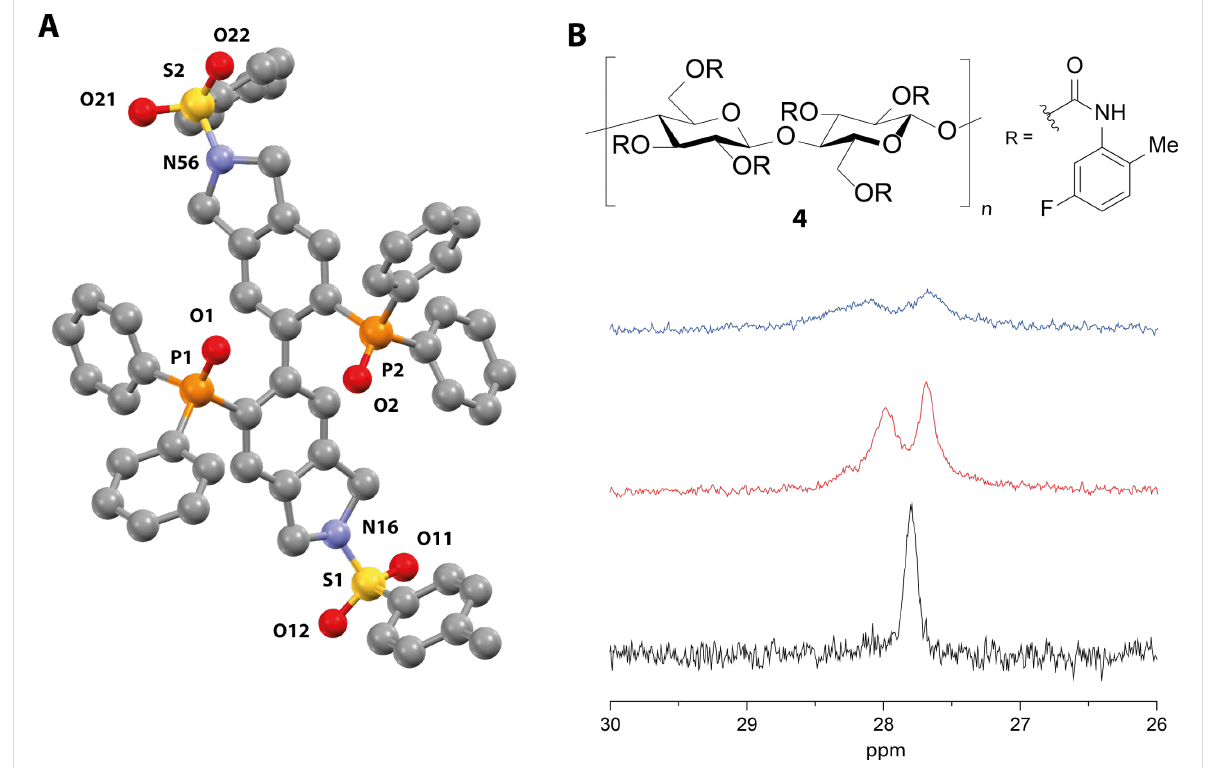
Figure 3: Investigation of “NU-BIPHEP(O)” 1b . A) Solid-state structure determined by X-ray crystallography. Hydrogen atoms and methanol solvent molecules are omitted for clarity. B) Interaction studies in solution with soluble Okamoto phase 4 by 31 P{ 1 H} NMR spectroscopy. Black: spectrum of